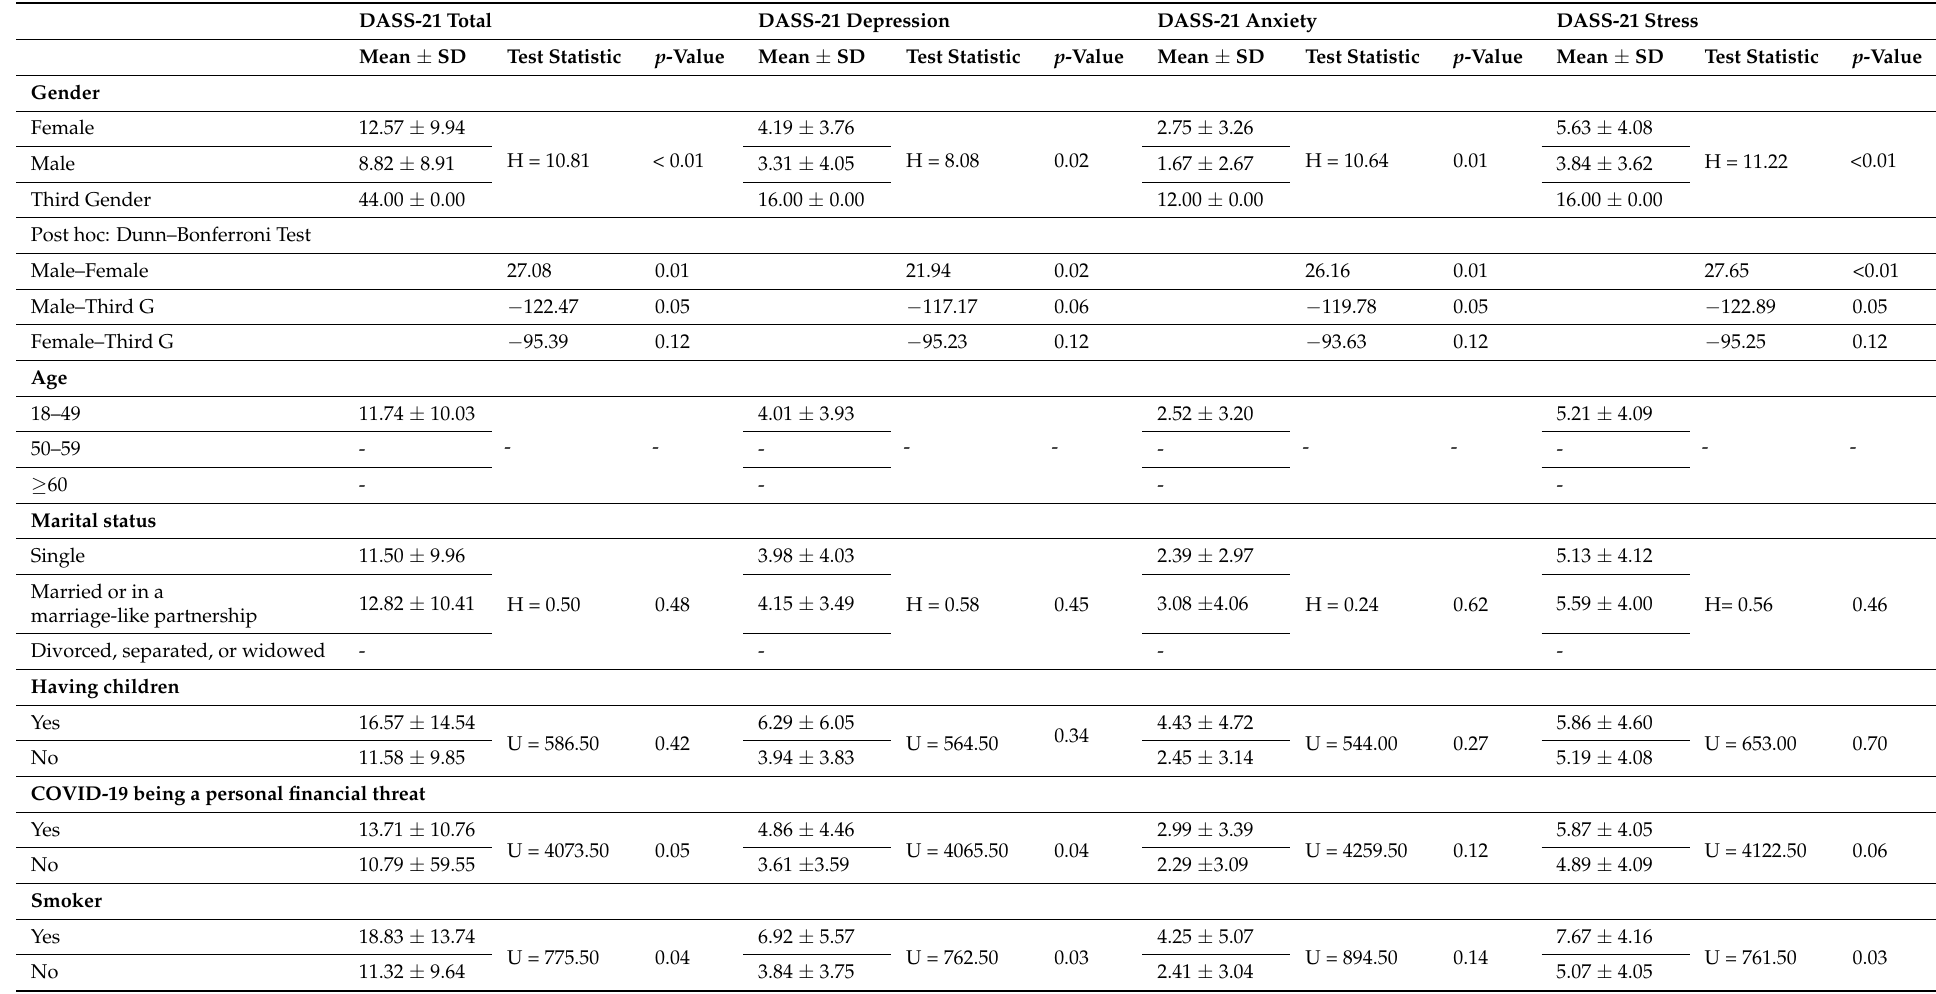
Table 4. Differences between participants’ characteristics regarding DASS-21 total and subscale